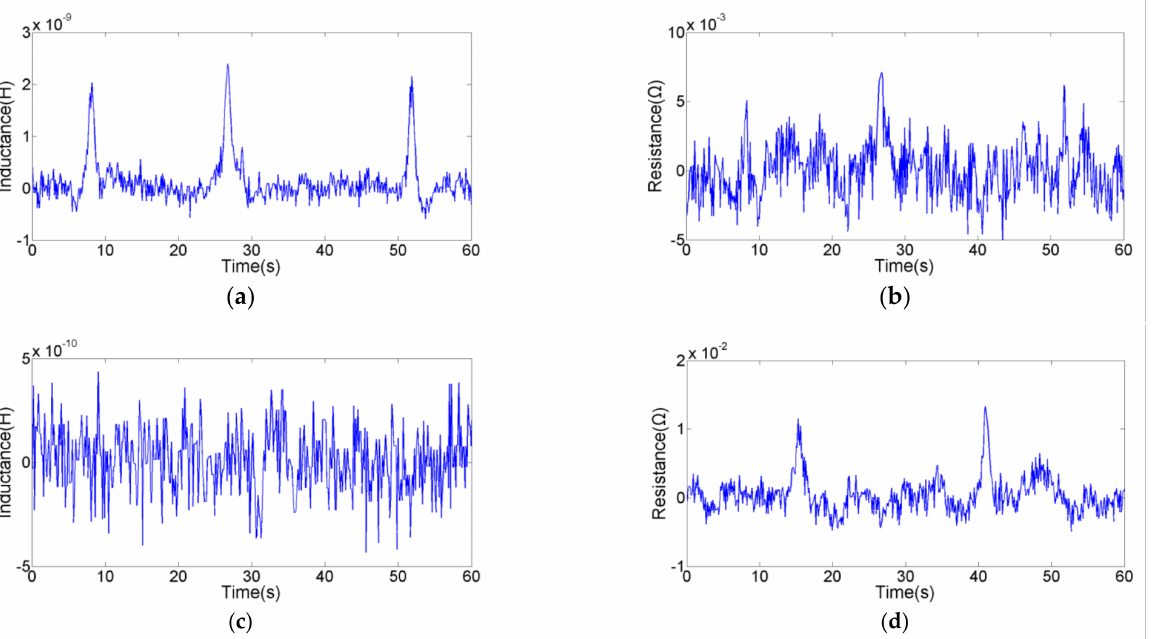
Figure 8. The floor level of resistance detection (with silicon steel strips): ( a ) inductance signal of 59 µ m iron particle; ( b ) resistance signal of 59 µ m iron particle; ( c ) inductance signal of 110 µ m copper particle; ( d ) resistance signal of 110 µ m copper particles.